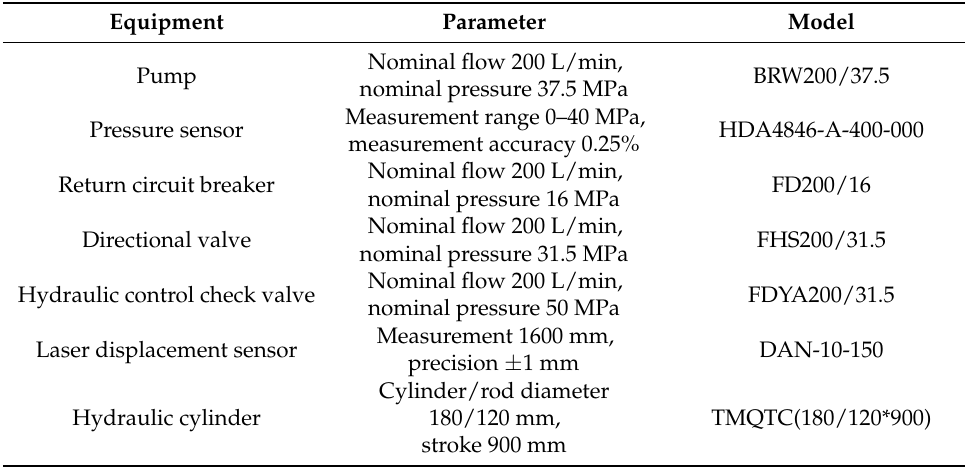
Figure 11. Hydraulic schematic diagram of the test system. Table 2. Equipment